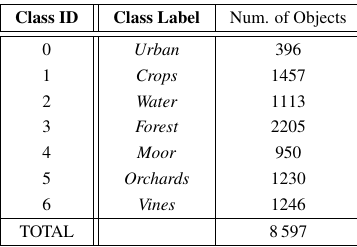
Table 1. Characteristics of the Dordogne study site